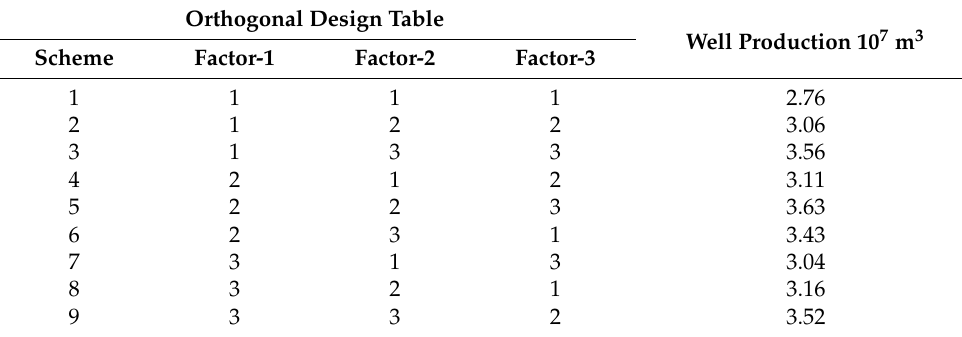
Figure 11. Cumulative gas production curve of single well after different development schemes of horizontal well. Table 5 is the production analysis table of different schemes of horizontal wells. Table 5. Production analysis table for different schemes of horizontal well.